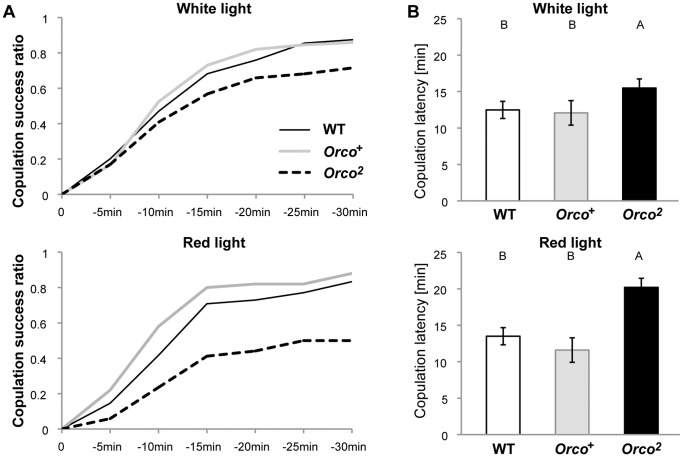
Copulation success of wild-type and olfactory mutant males.In order to investigate how the song choice affects female receptivity, intact wild-type females were paired with WT, Orco+ or Orco2 males and numbers of successful copulation were counted under white (top panels) or dim-red light (bottom panels) conditions. A) Cumulative proportion of pairs reaching successful copulation over time. B) Copulation latencies of males of each genotype. ≥38 males were tested for each genotype and experimental condition. Different letters signify significant differences between groups (p<0.05).